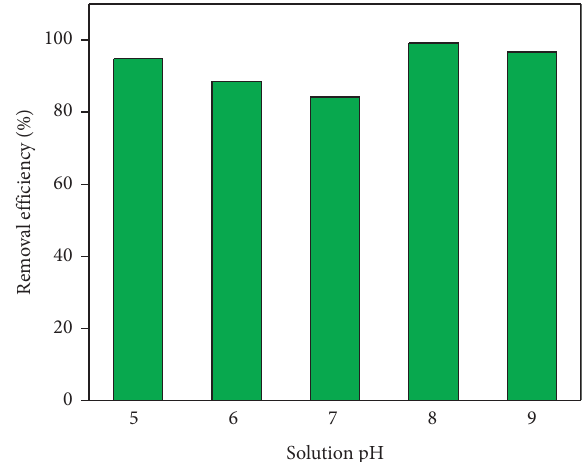
Figure 5: Effects of the pH solution (0.15g TNT-500, 1 UV-A light bulb, 90min of reaction